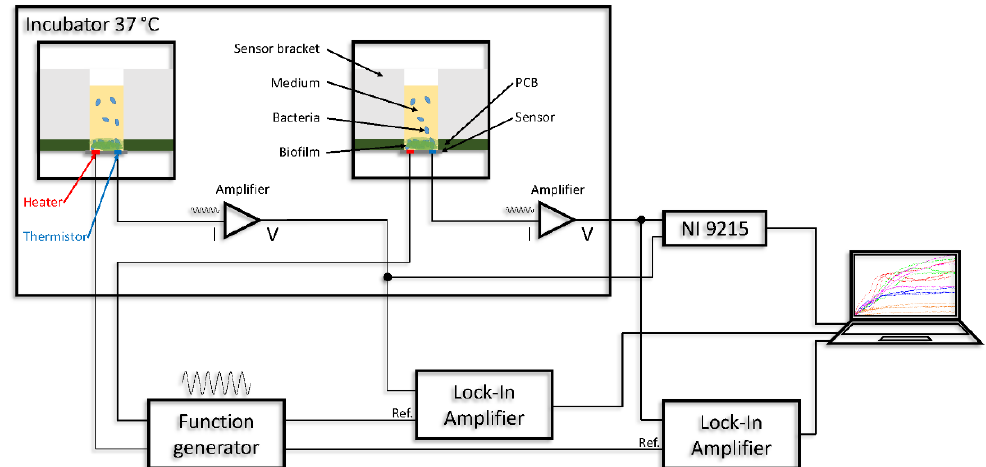
Figure 3. Thermal sensor measurement setup with all components for carrying out the experiments. Integrated function generator shown separately for clarity.